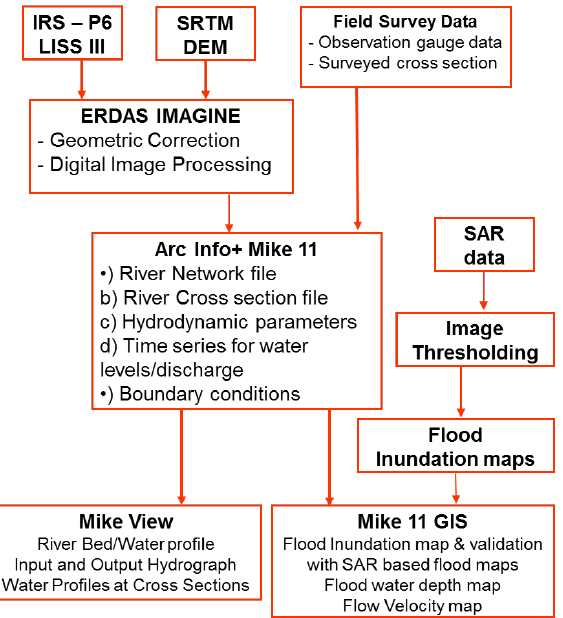
Fig. 2.2. Flowchart for flood inundation mapping and 1-HD modelling and visualization (modified after Thakur & Sumangla 2006)